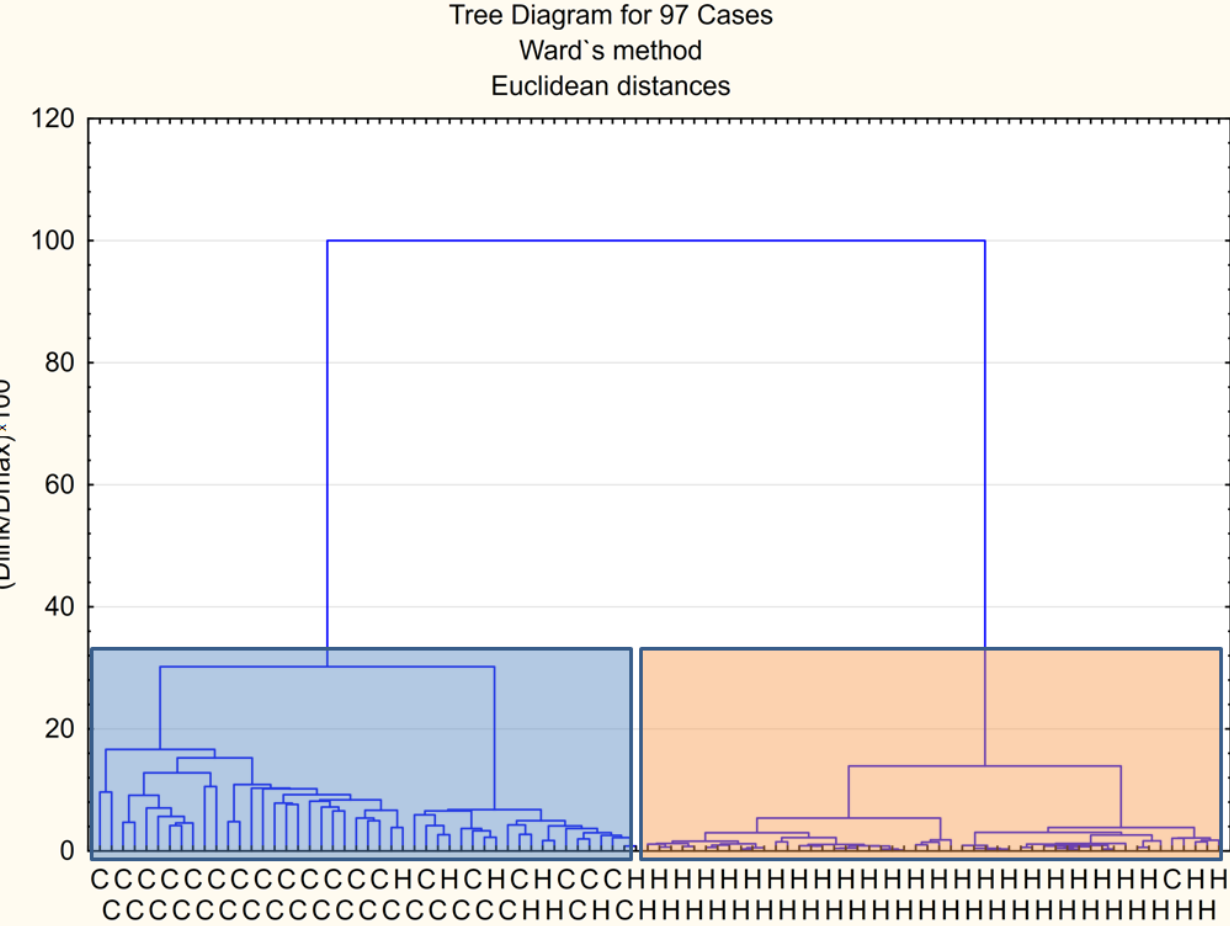
Figure 1. Dendrogram based on the cluster analysis. The discriminant analysis followed by the computation of canonical roots was per- formed with and without “negative markers”. The backward stepwise analysis was chosen. Eighthealthy people and sevencancer patients were exuded from the building of the classi- fier. Those cases were used to cross-validate the model. In the first option, discriminant functions were computed more efficiently than in the second one (Wilk (cid:48) s Lambda equal to 0.197 and 0.294). The canonical analysis revealed that only one root is necessary to discriminate between both groups (Figure 3). One cancer patient was misclassified (the case of the model building) when all the compounds were used for the data analysis, in contrast to the second version, in which some cases of the both groups overlapped each other within a certain range (threeand four cases from the heathy and BC cross-validation groups,